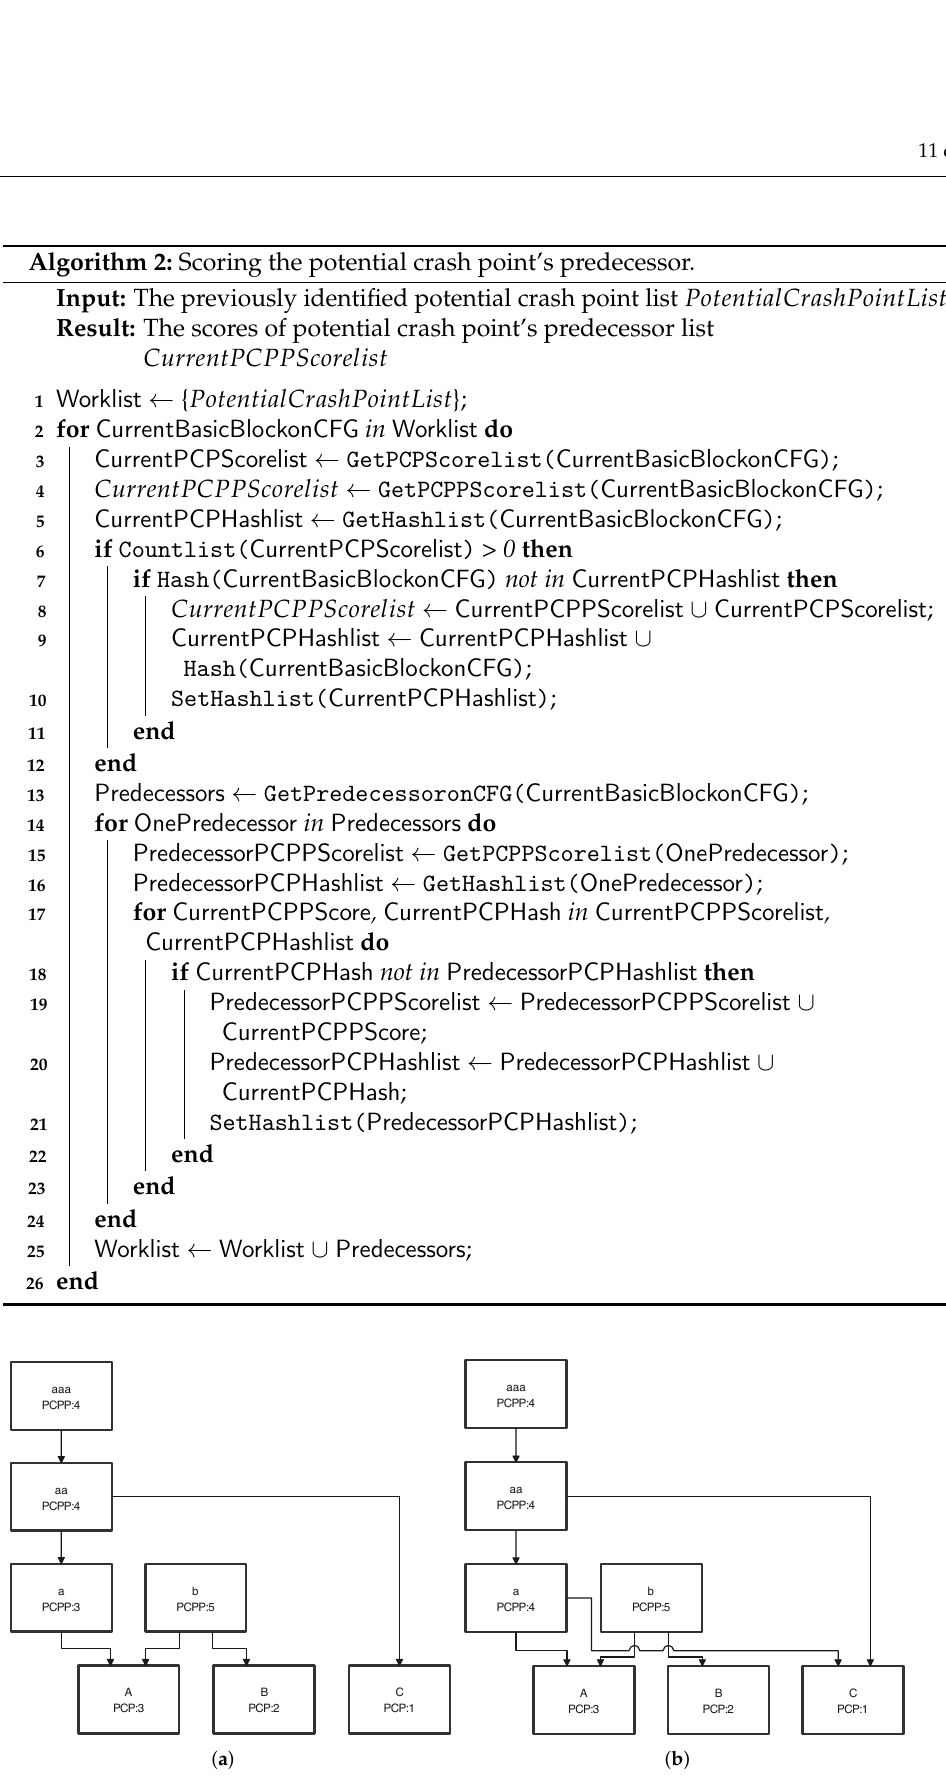
Figure 4. Scoring PCPP. ( a ) Scoring the potential crash point’s predecessor. ( b ) Scoring the potential crash point’s predecessor with reduplicate